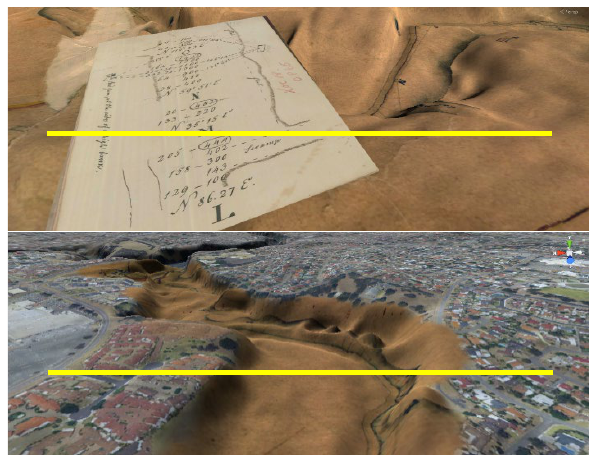
Figure 1 2 : Top: Historical Map visualised with DEM in Unity with associated field sheet. Bottom: Modern aerial photography and historical map combined with DEM in Unity visualisation. The yellow bar indicates the same